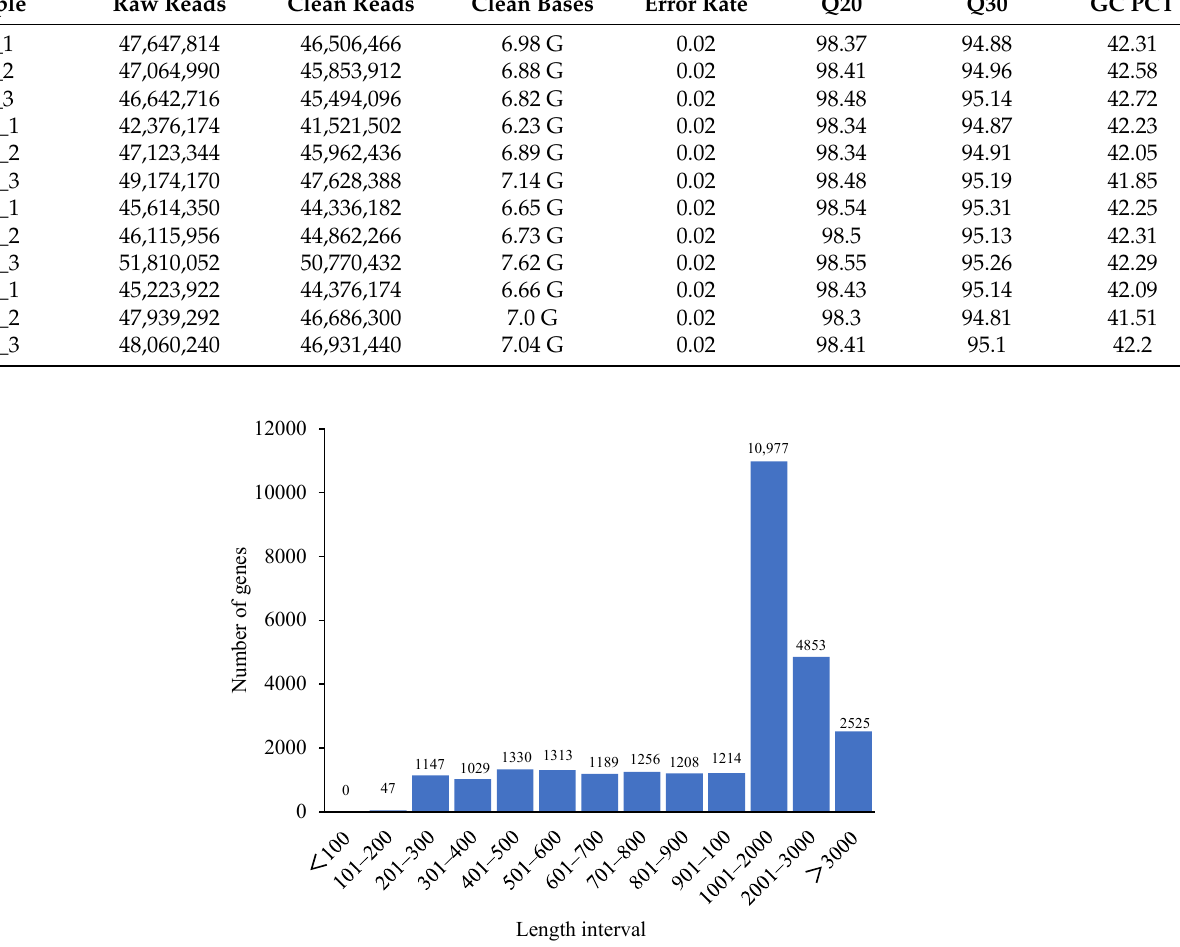
Table 1. RNA-sequencing quality.